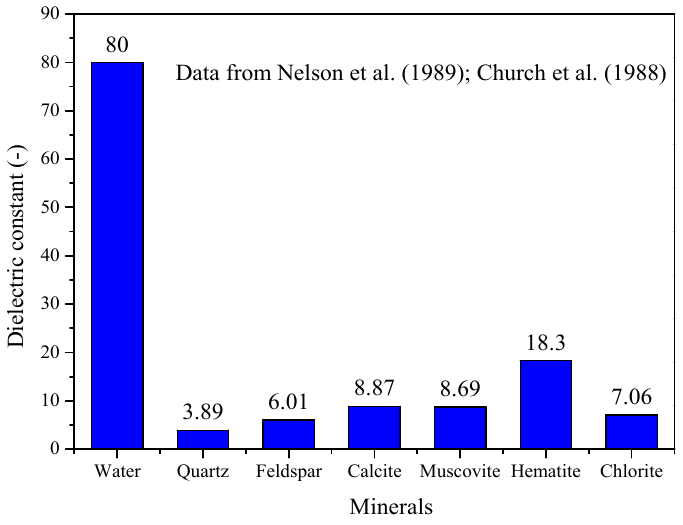
from Nelson et al. (1989); Church et al. (1988)